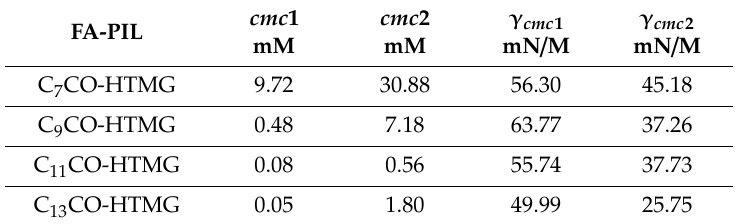
Table 2. Critical micelle concentrations ( cmc ) and surface tension at cmc ( γ cmc ) values of the FA-PILs under